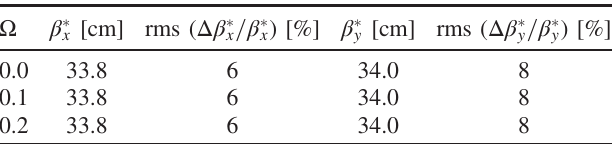
TABLE III. Reconstructed average and uncertainty of β (cid:1) from K modulation for β (cid:1) ¼ 30 cm optics configuration.